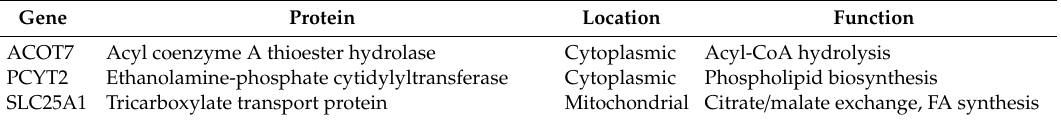
Table 1. Genes differentially expressed in brain metastasis of breast cancer patients compared to other metastases.